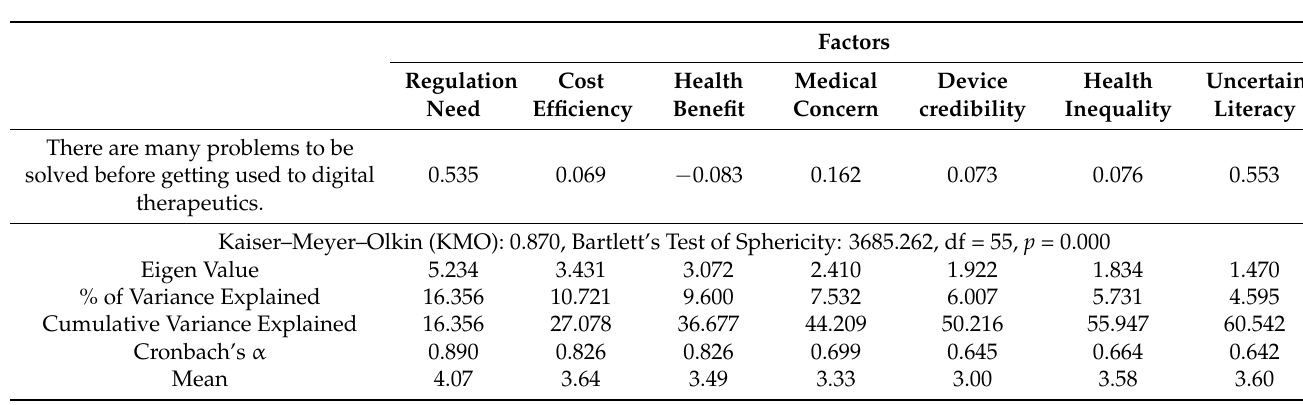
Table 3. Cont. Regulation Need